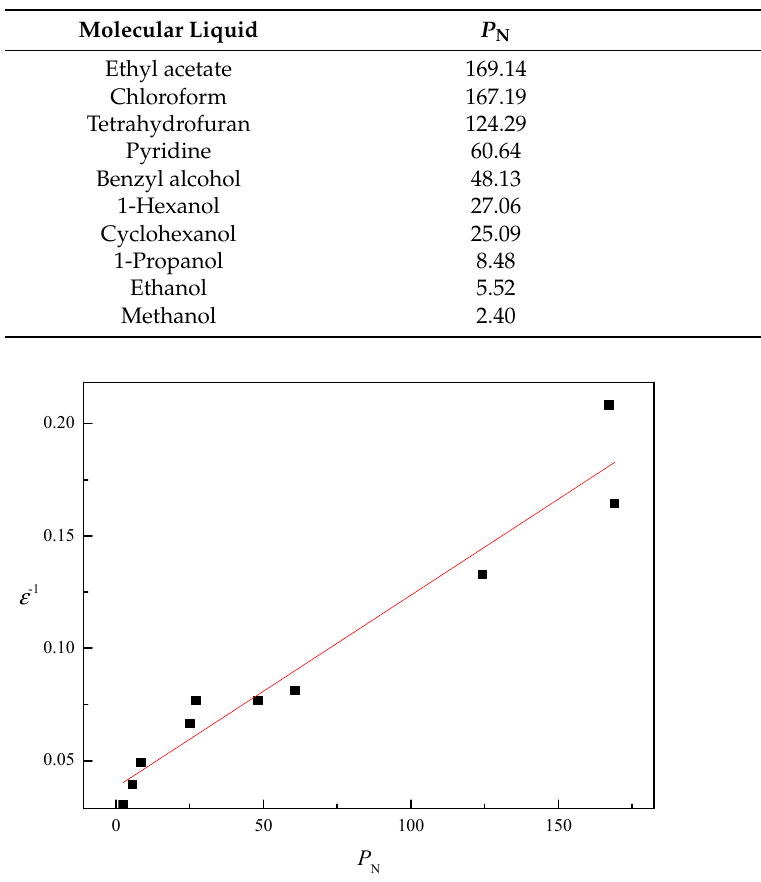
Figure 5. Inverse of the dielectric constant ( ε − 1 ) of various molecular liquids plotted against the estimated polarity P N . Linear correlation coefficient ( r 2 ) 0.94.